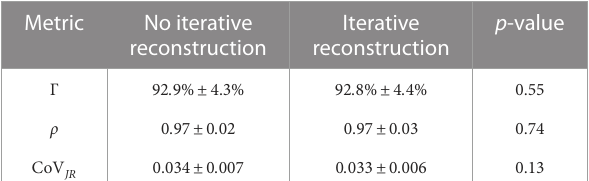
TABLE2 Quantitativemetricsforsimilaritybetweenventilationmaps derivedfor4DCTscanswithdifferentnoiselevelsarelisted.Resultswith andwithoutIRarelistedseparatelyandwerecomparedusingastudent’s t -testandhave p -valueslistedintherightmostcolumn.